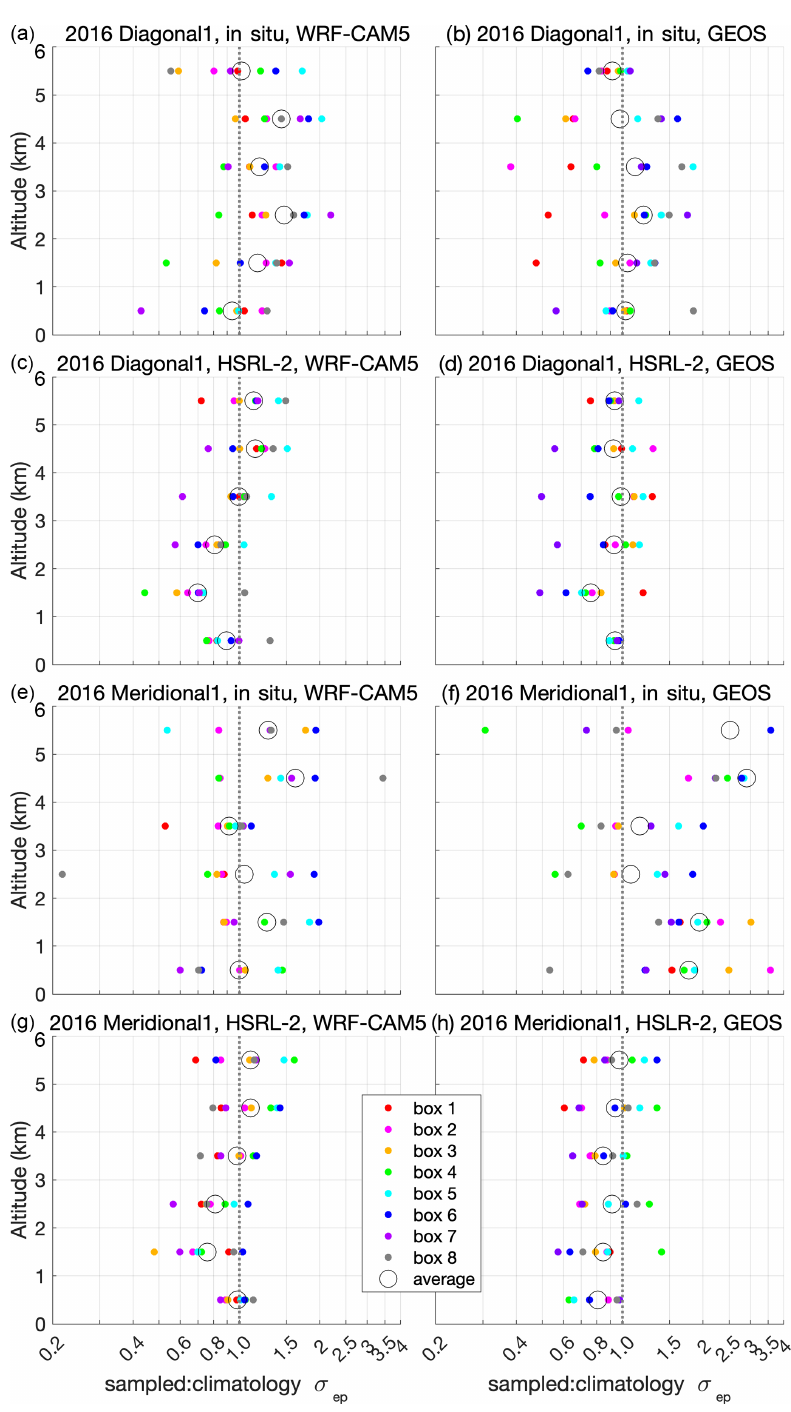
Figure 3. The ratio in the mean of σ ep modeled by WRF-CAM5 ( a, c, e, g ) and GEOS ( b, d, f, h ) for only those times when observed values are available (sampled) to the mean of σ ep across the entire field campaign time period (climatology) in the (a–d) diagonal transect in September 2016 and the (e–h) meridional 1 transect in September 2016. The representativeness of both the in situ (a, b, e, f) and HSRL-2 (c, d, g, h) observations of σ ep are shown. The color dots show the means within individual comparison grid boxes; open circles are the mean across all grid boxes in that transect. Note that, in panel (f) , there is a single grid box data point that is off scale (sampled : climatology σ ep >